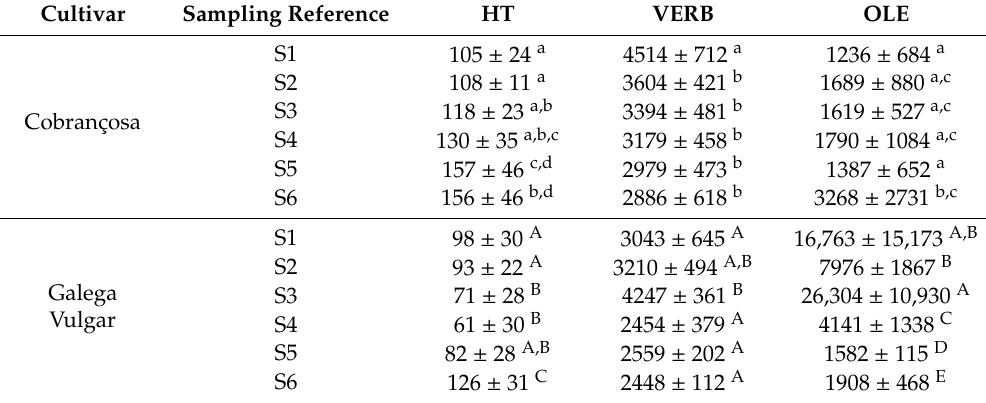
Table 3. Quantification of hydroxytyrosol (HT), oleuropein (OLE) and verbascoside (VERB) (mg / Kg of olive pulp) over six di ff erent ripening stages (S), for ‘Cobrançosa’ and ‘Galega Vulgar’ cultivars (mean ± standard